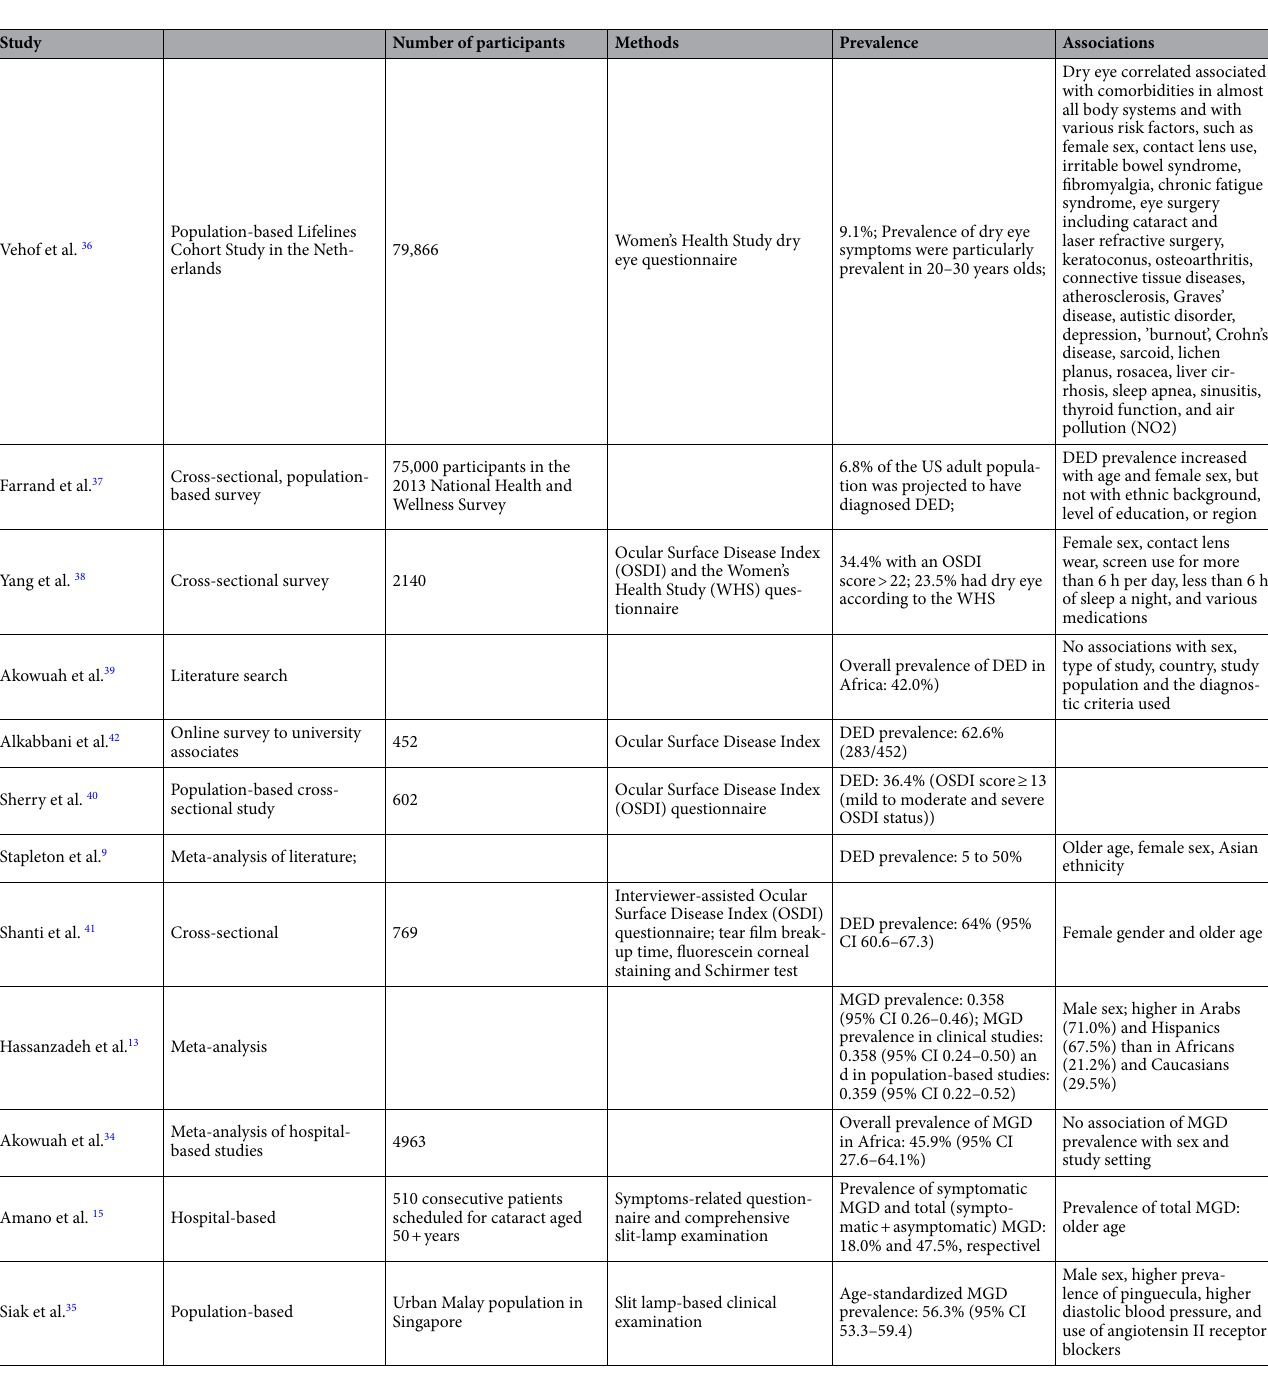
Table 6. Previous studies on the prevalence of dry eye disease and Meibomian gland